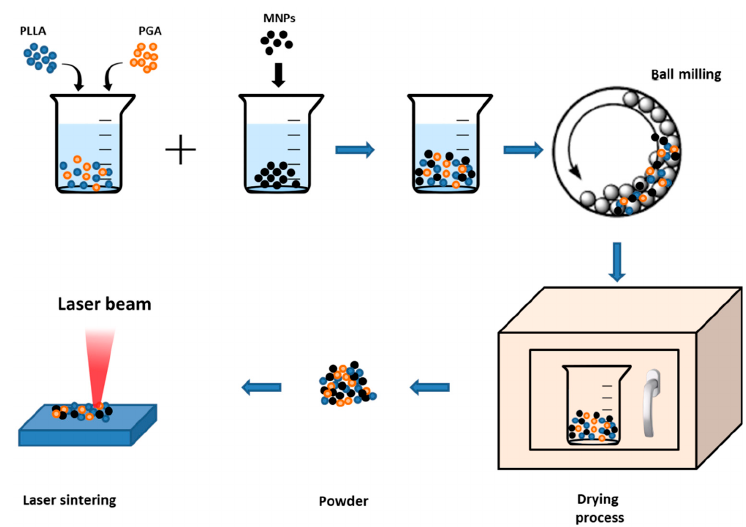
Figure 2. Schematic representation of the procedure used to obtain the scaffolds in [92]. A powder of well-dispersed poly-l-lactide (PLLA)-polyglycolic acid (PGA) and magnetic responsive nanoparticles (MNPs) mixture was synthetized, melted by means of a laser and then solidified to obtain the paramagnetic scaffold.